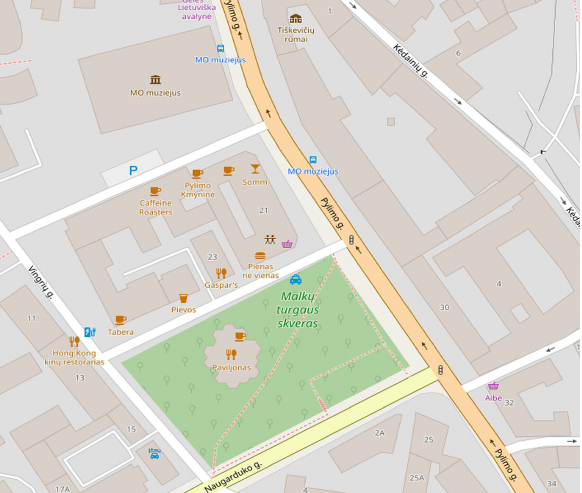
Figure 13. UAV camera images showing G (cid:12) center and M (cid:12) museum area at different angles. The red mark indicates a detected façade shape. Color highlights show assigned segment masks.